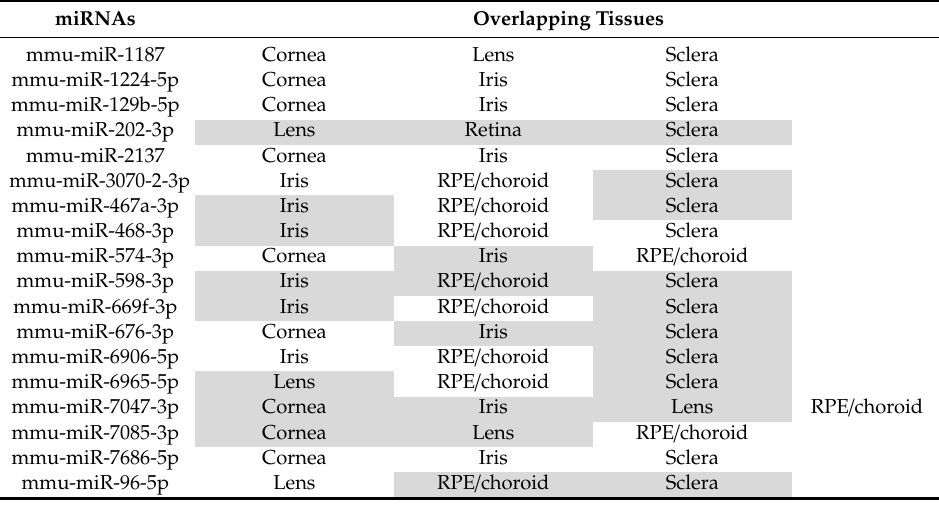
Table 7. Overlapping expression changes in miRNAs between more than three types of ocular tissue. Note that grey highlights indicate downregulated